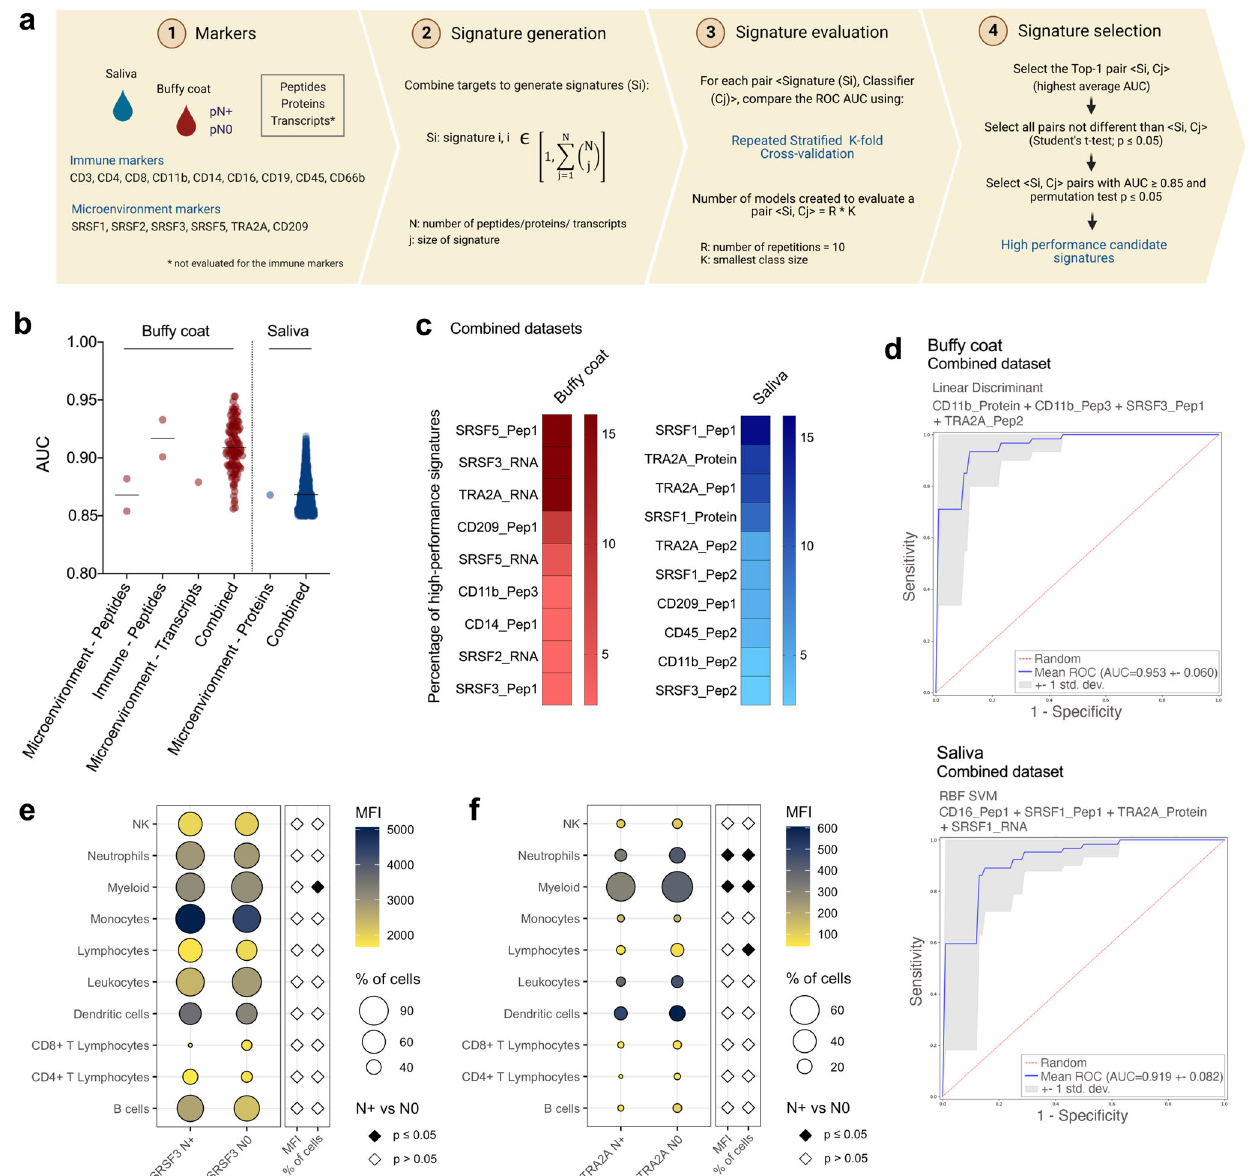
Fig.6|De fi nitionofthebestprognosticsignaturesinliquidbiopsiesaccording to machine learning. a Design used to determine the signatures of lymph node metastasis with the best performance according to ML. Created with BioR- ender.com. b High-performance signatures determined for buffy coat and saliva individual and combined datasets after fi ltering for ROC AUC ≥ 0.85 and permu- tation p ≤ 0.05. The solid line represents the means for each dataset. c Percentage ofmarkersamongthebuffycoat(leftpanel)andsaliva(rightpanel)signaturesthat exhibited high performance in regard to discriminating pN+ and pN0 patients. Combined datasets containing peptide, protein, and transcript data for the 15 markers were considered. d ROC curves indicating the top-1 pairs <Si, Cj> in buffy